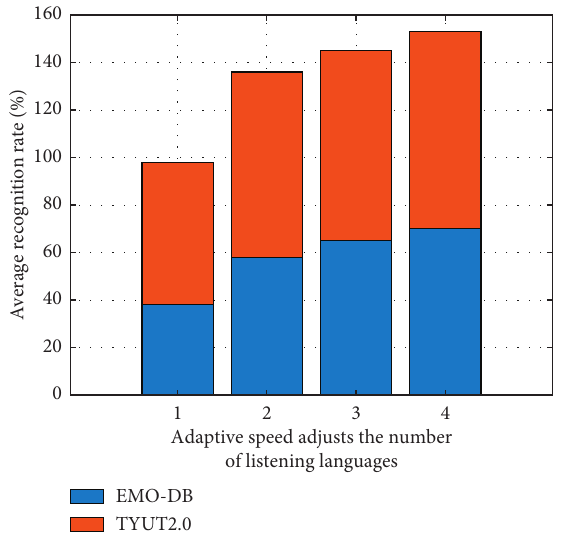
Figure 8: Histogram of average recognition rate of two language databases. Table 4: Experimental results of the application of the long binary probability to the refined English listening and audio language binary